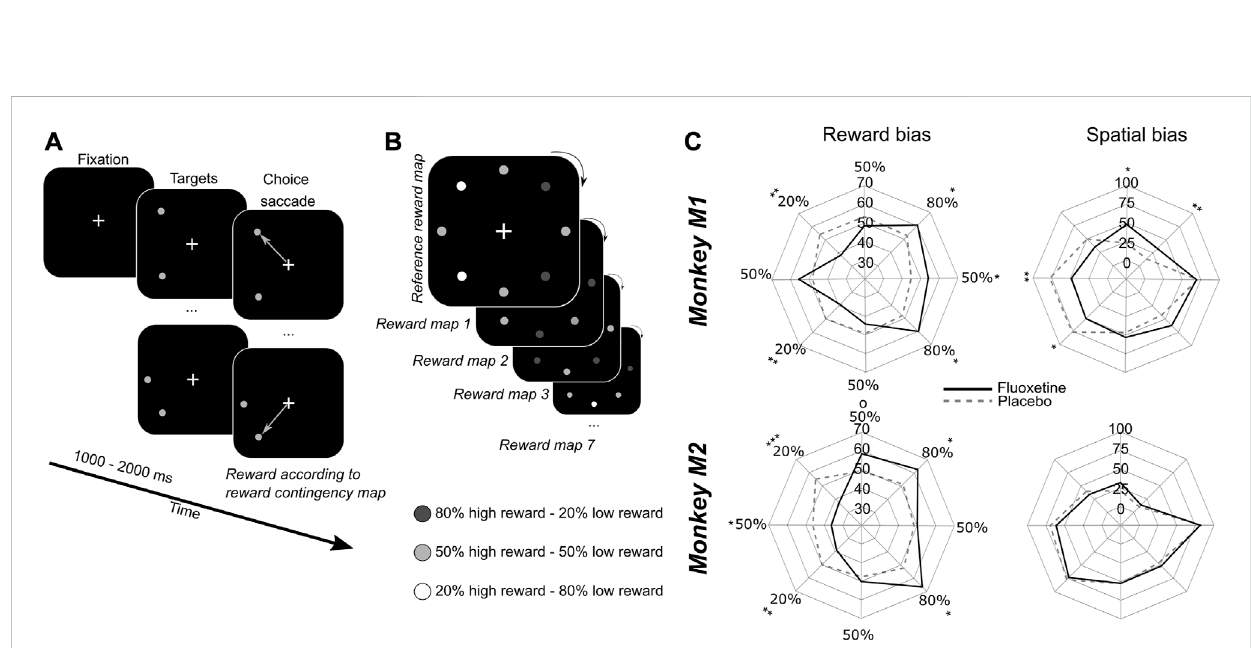
FIGURE 3 Effect of fl uoxetine on saccadic choices towards targets of different reward contingencies. (A) Monkeys had to fi xate a central cross on a screen 60 cm away from their eyes. After an interval of 1 – 2 s, two stimuli appeared simultaneously at two different locations out of eight. All of the 8 possible targetlocations wereorganizedalongavirtualcircleof8 ° ofeccentricityfromthe fi xationcross,equidistantonefromtheother.Monkeyswererewarded to make a saccadic eye movement to any of the two targets. (B) Each target was associated with two possible reward quantities, but with a different probability. High expected reward targets were associated with 80% of high reward probability and 20% of low reward probability. Low expected reward targets were associated with 20% of high reward probability and 80% of low reward probability. Intermediate expected reward targets were associated with 50% of high reward probability and 50% of low reward probability. Reward contingencies between neighbors were kept constant as follows: 80% high reward (HR) — 50% HR — 80% HR — 50% HR — 20% HR — 50% HR — 20% HR — 50% HR. However, the actual location of high and low rewarding targets changed pseudo-randomly from 1 day to the next. Thus, monkeys had to learn the new reward contingencies every day. We did not evaluate how much monkeysbuiltarepresentationofthereferencecontingencymap. (C) Polarplotsrepresenttheprobabilitythatmonkeyschooseanygiventargeteitheras a function of the reward contingency map (i.e., irrespective of actual spatial position, left) or as a function of the spatial map (i.e., irrespective of actual reward contingency maps, right). Median are presented for placebo (dashed lines) and fl uoxetine (continuous lines) conditions. Statistical signi fi cance is represented as follows: ***, p < 0.001; **, p < 0.01; *, p < 0.05. See also companion Supplementary Tables S4, S5 for detailed statistics.